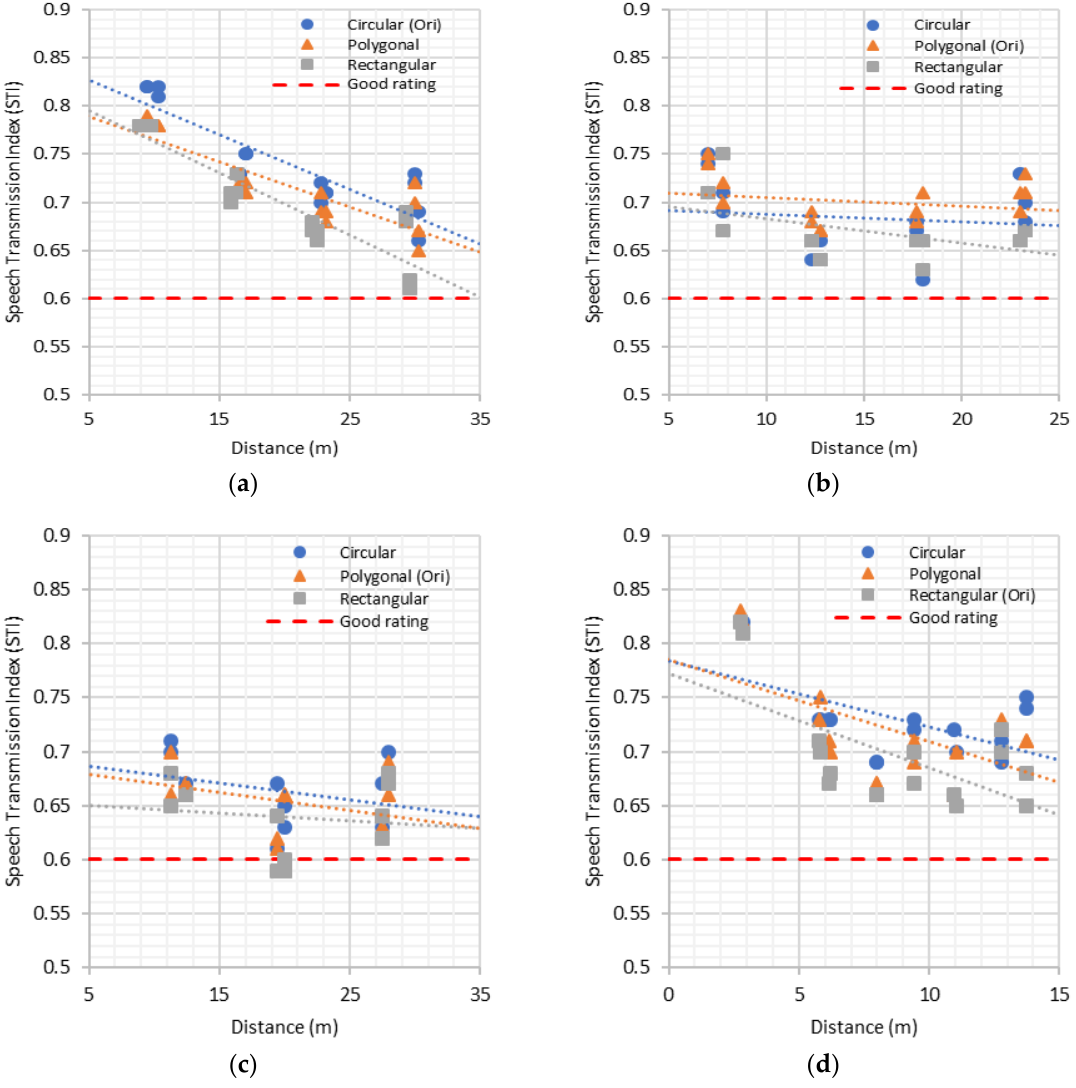
Figure 4. Comparison of the average STI among the various chancel shapes: ( a ) C1; ( b ) P1; ( c ) P2; ( d ) R1. (Blue, orange, and grey dotted lines are the trendlines for circular, polygonal, and rectangular church data, respectively).